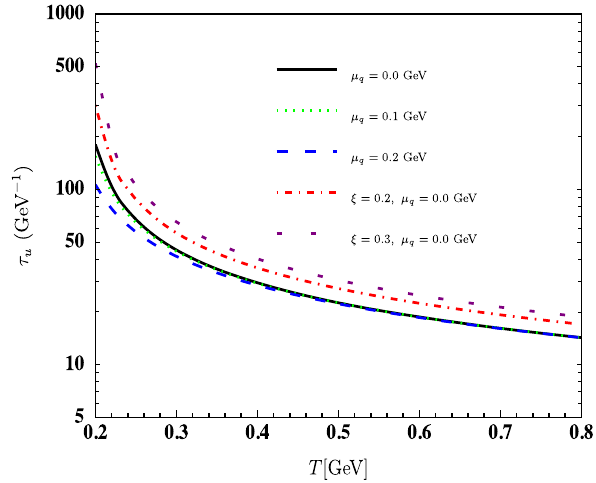
Fig. 1 The temperature dependence of the thermal relaxation time for u quarks ( τ u ) at different quark chemical potentials, viz, μ q =0.0 GeV (black solid line), 0.1 GeV (green dotted line) and 0.2 GeV (blue dashed line) for B = 0. The estimation of τ u at μ q = 0 . 0 GeV is also extended to the anisotropic medium induced by initial spatial expansion with ξ = 0.2 (red dotted-dashed line) and 0.3 (purple short-dashed